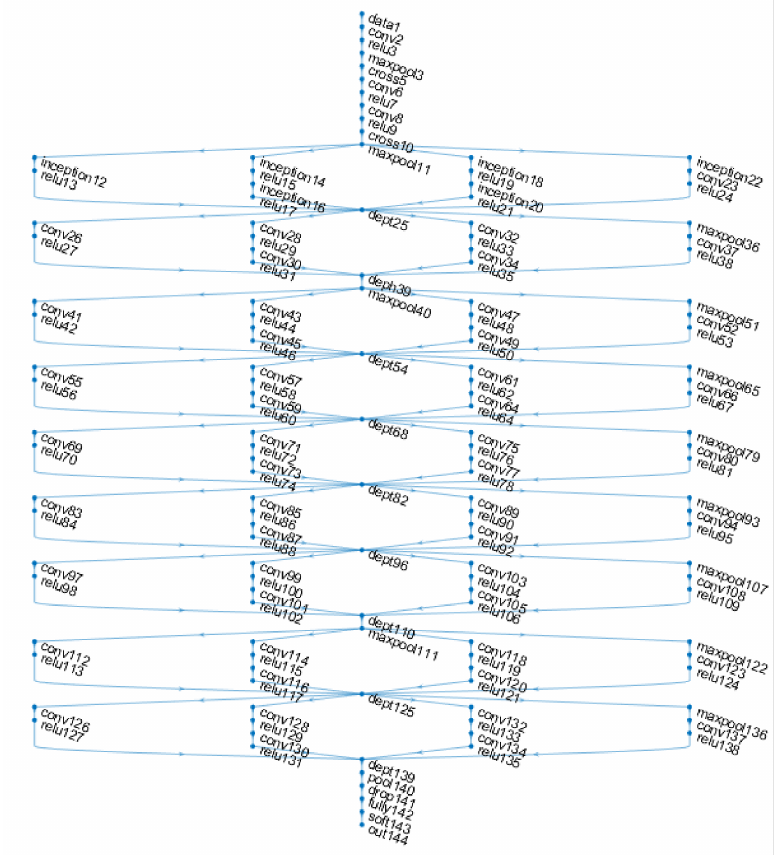
Figure 1. Google Net network architecture